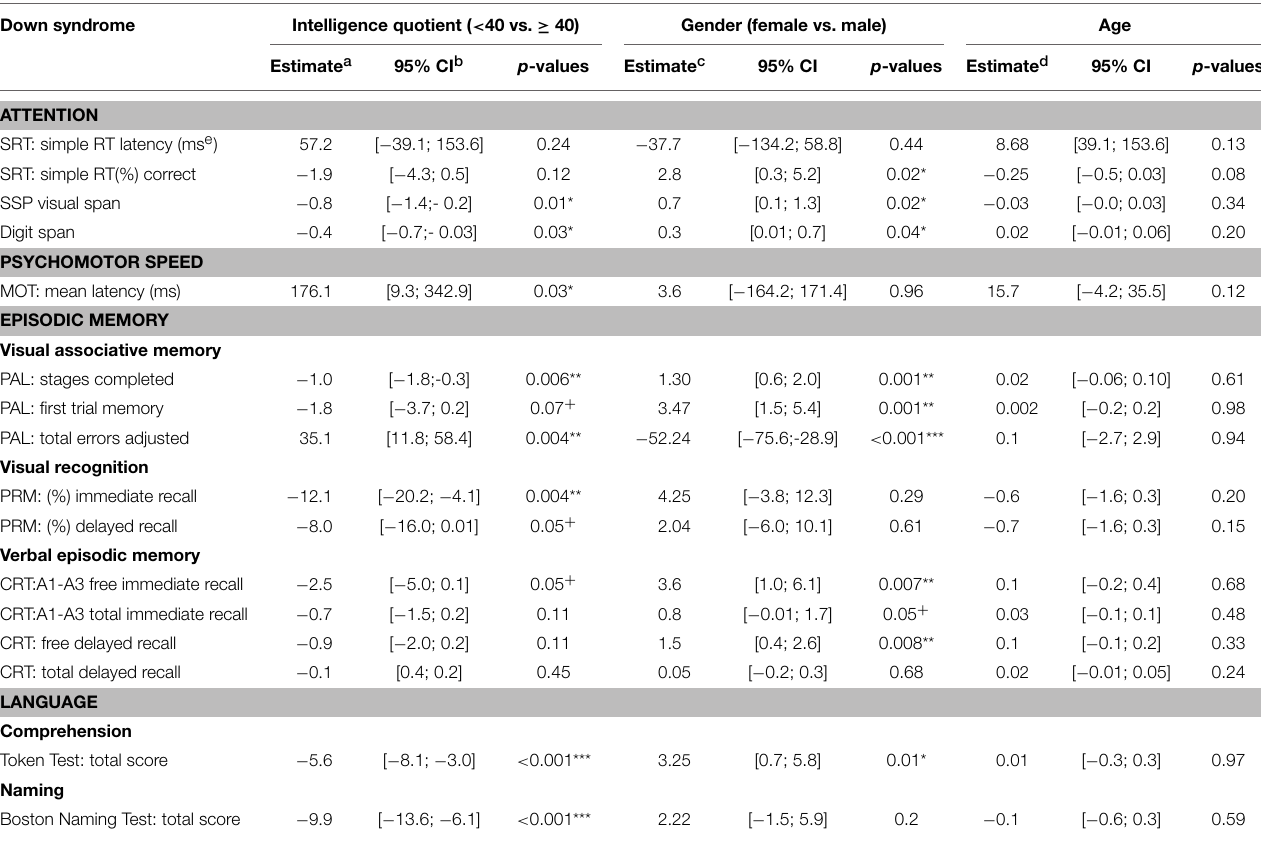
TABLE 3 | Impact of intellectual quotient, gender, and age on attention, psychomotor, memory, and language performance in Down syndrome participants. Down syndrome Intelligence quotient ( < 40 vs. ≥